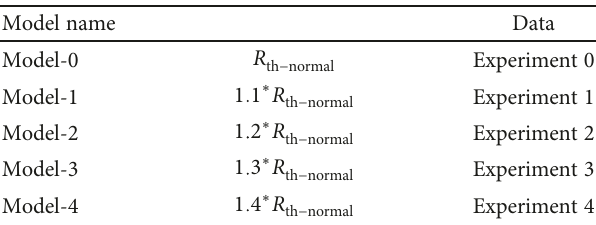
Figure 18: The correlation between the output and target power loss. Table 3: The prediction